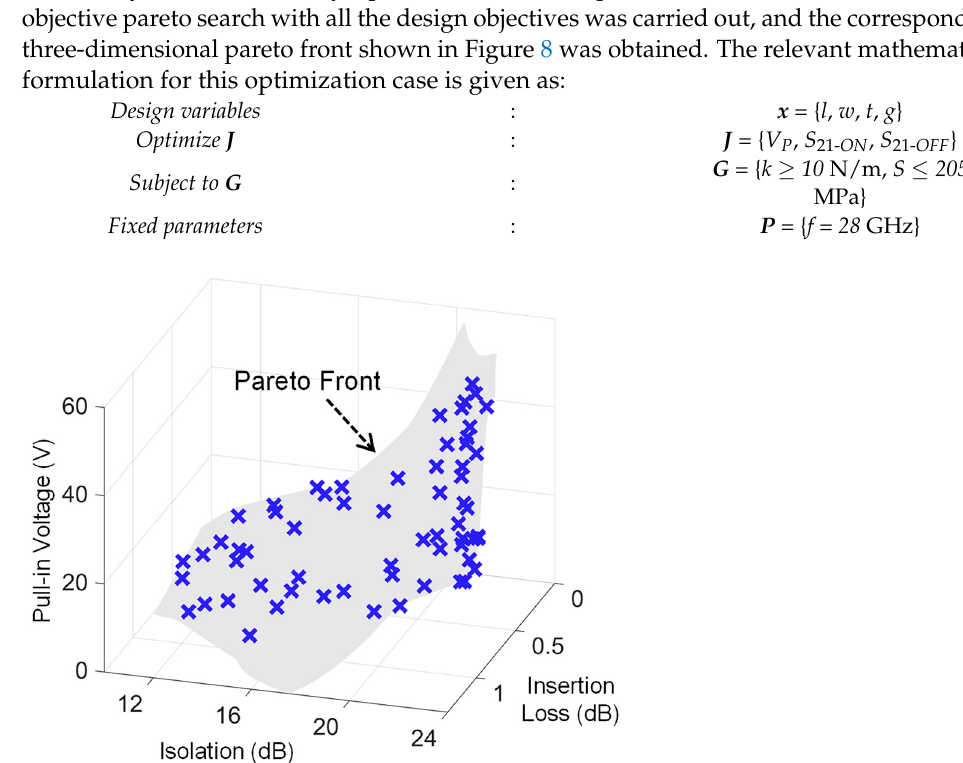
Figure 8. Three-dimensional pareto front demonstrating trade-off among actuation voltage, RF isolation, and insertion losses for the RF-MEMS series switch.